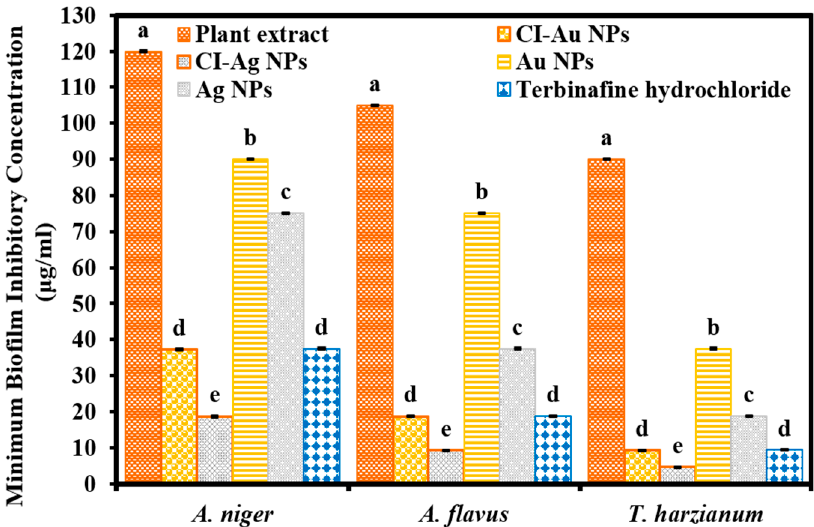
Figure 8. Biofilm inhibition activity of green synthesized CI-Au NPs, and CI-Ag NPs in terms of MBICs against different mycological strains in comparison to C. inerme leaves extract, commercially purchased Au and Ag NPs, as well as an antifungal drug. (Note: Tukey based heterogenous lower-case letters represent significant statistical pairs) .